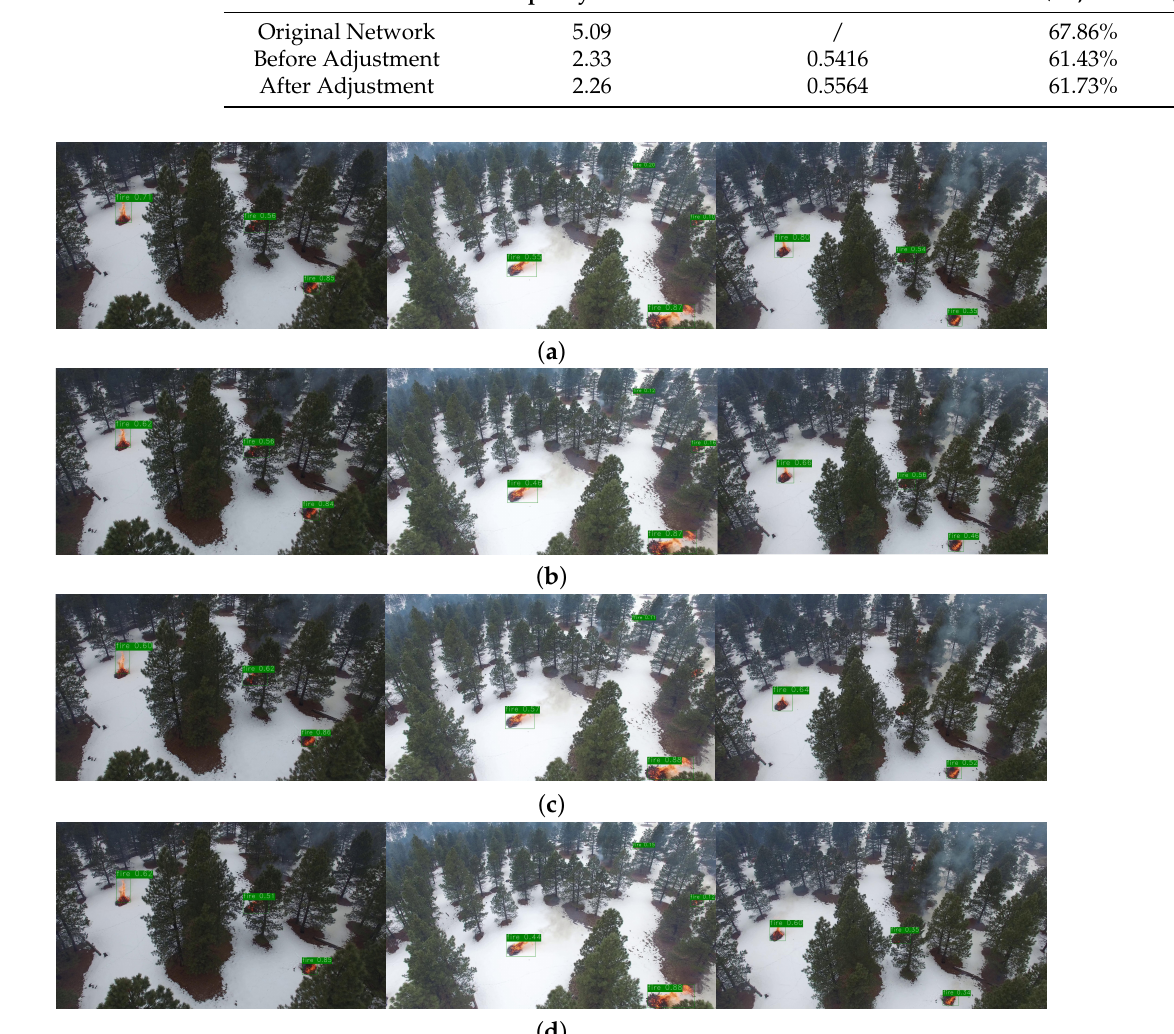
Figure 13. Inference effects using actual forest scene images on the FPGA platform used in each experimental stage. ( a ) The results of the inference test for the original model. ( b ) The test results of the model inference fully quantified by QAT. ( c ) The test results of model inference with FPGM pruning and regular pruning. ( d ) The test results of model inference with pruning and